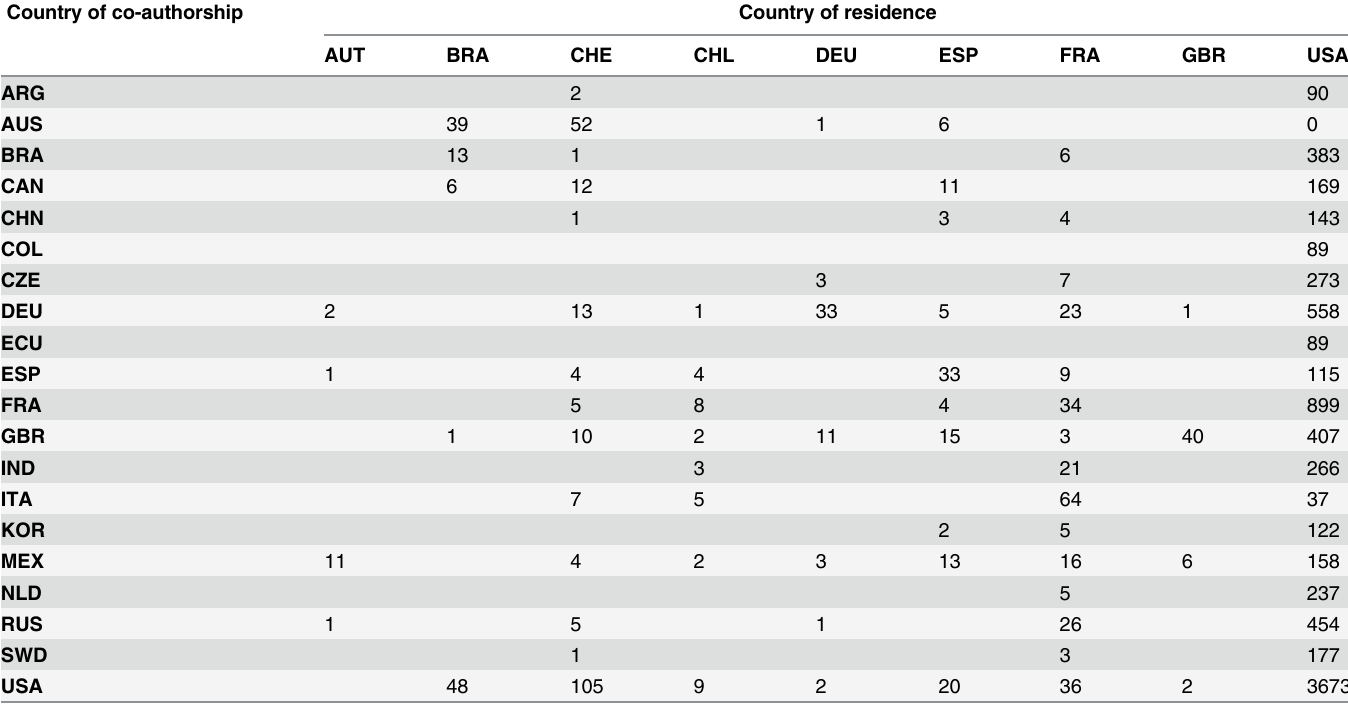
Table 6. Distribution of co-authorships for the 2007 papers published by the scientific Mexican Diaspora in the physical sciences by country of residence vs. countries of co-authorship (2000 – 2013). Country of co-authorship